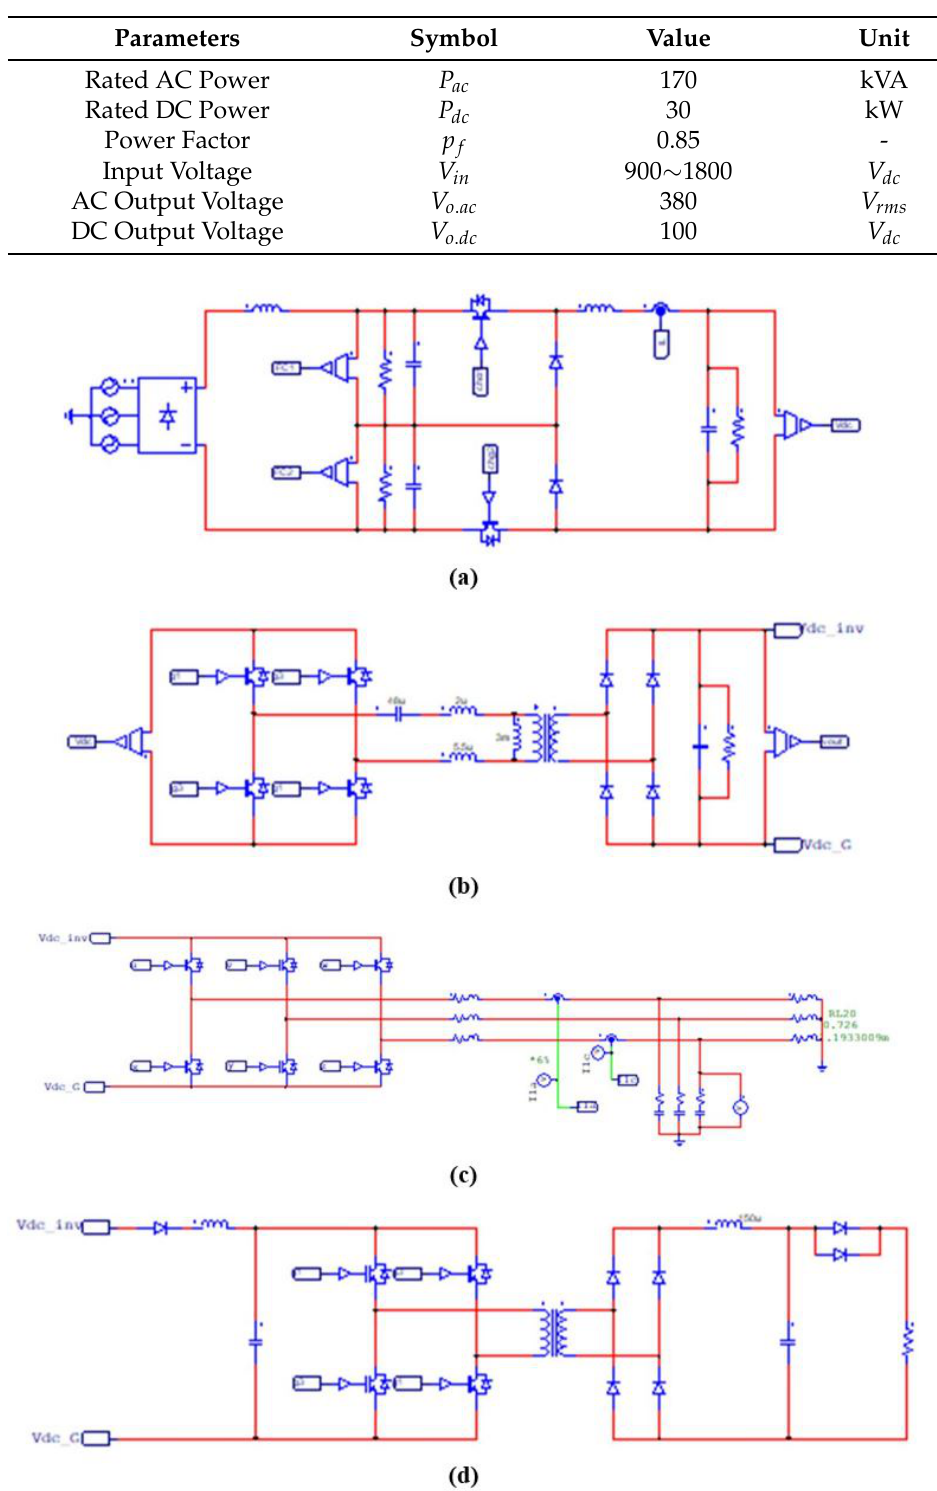
Figure 18. Simulation